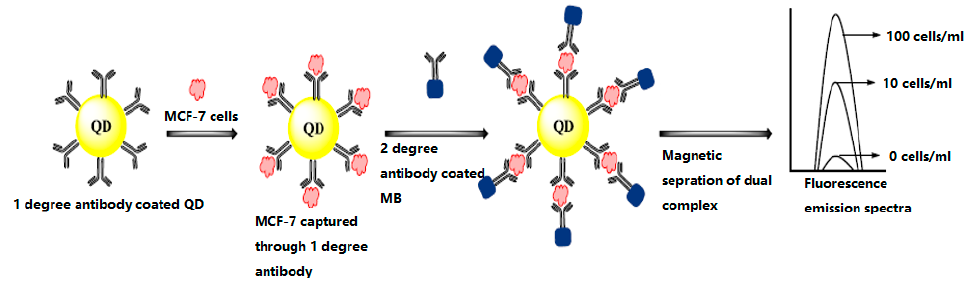
Figure 6. Quantum dot based optical biosensor for detection of MCF-7 cells.